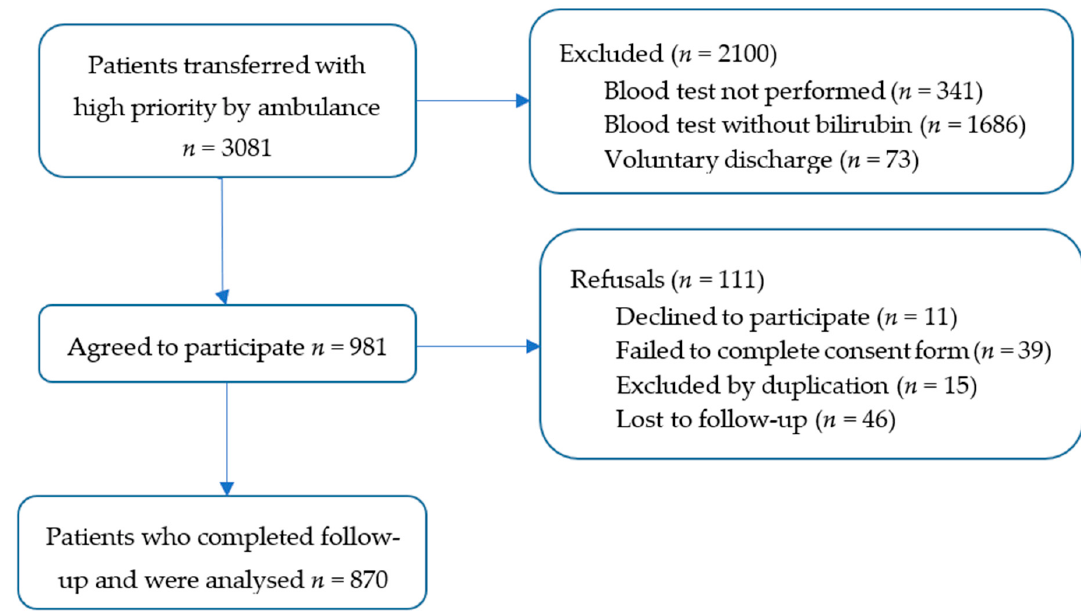
Figure 1. Flowchart of the study participants.